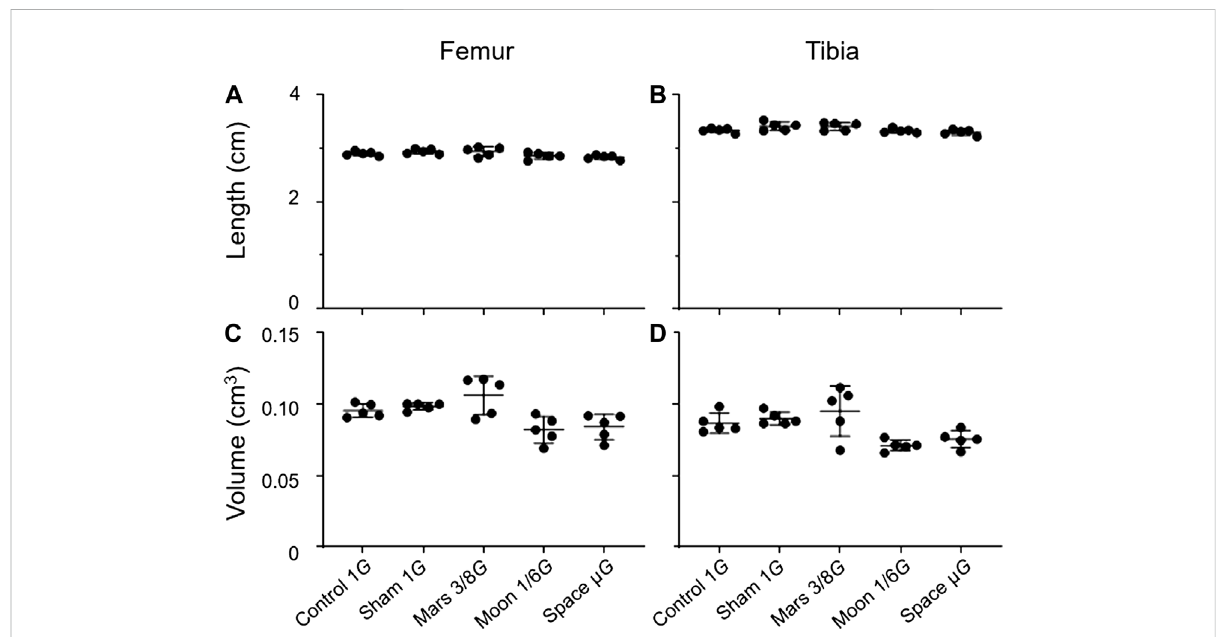
FIGURE 3 Lengthsandvolumesofthefemurandtibia. (A) Femorallength, (B) tibiallength, (C) femoralvolume,and (D) tibialvolume(Mean±SD,one-way analysis of variance).